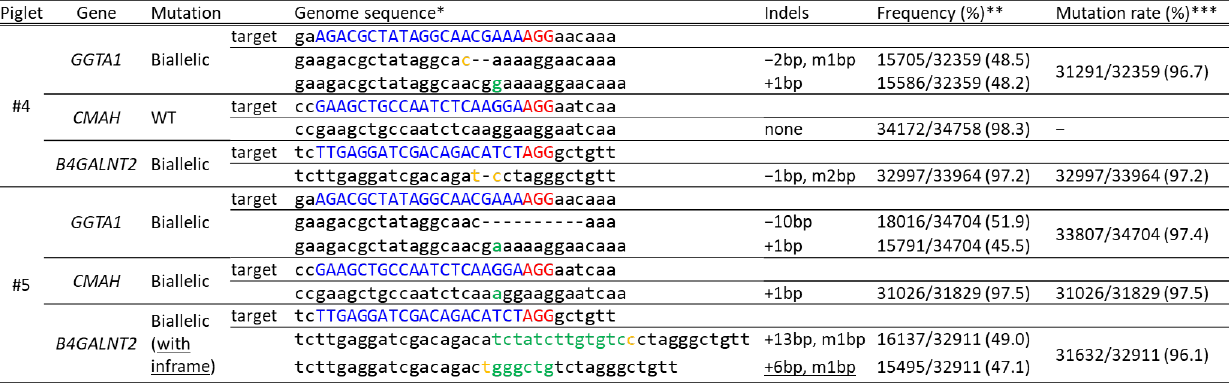
Figure 5. Deep sequencing analysis of the GGTA1 , CMAH , and B4GALNT2 target regions in delivered piglets. * Blue and red indicate the target sequences and PAM sequences of each gRNA, respectively. Green and yellow indicate inserted and modified sequences, respectively. ** The frequency was defined as the ratio of the number of amplicons to the total read number. *** The mutation rate was defined as the ratio of the total number of mutant amplicons to the total read number. WT, wild-type. Underlining indicates the presence of an inframe